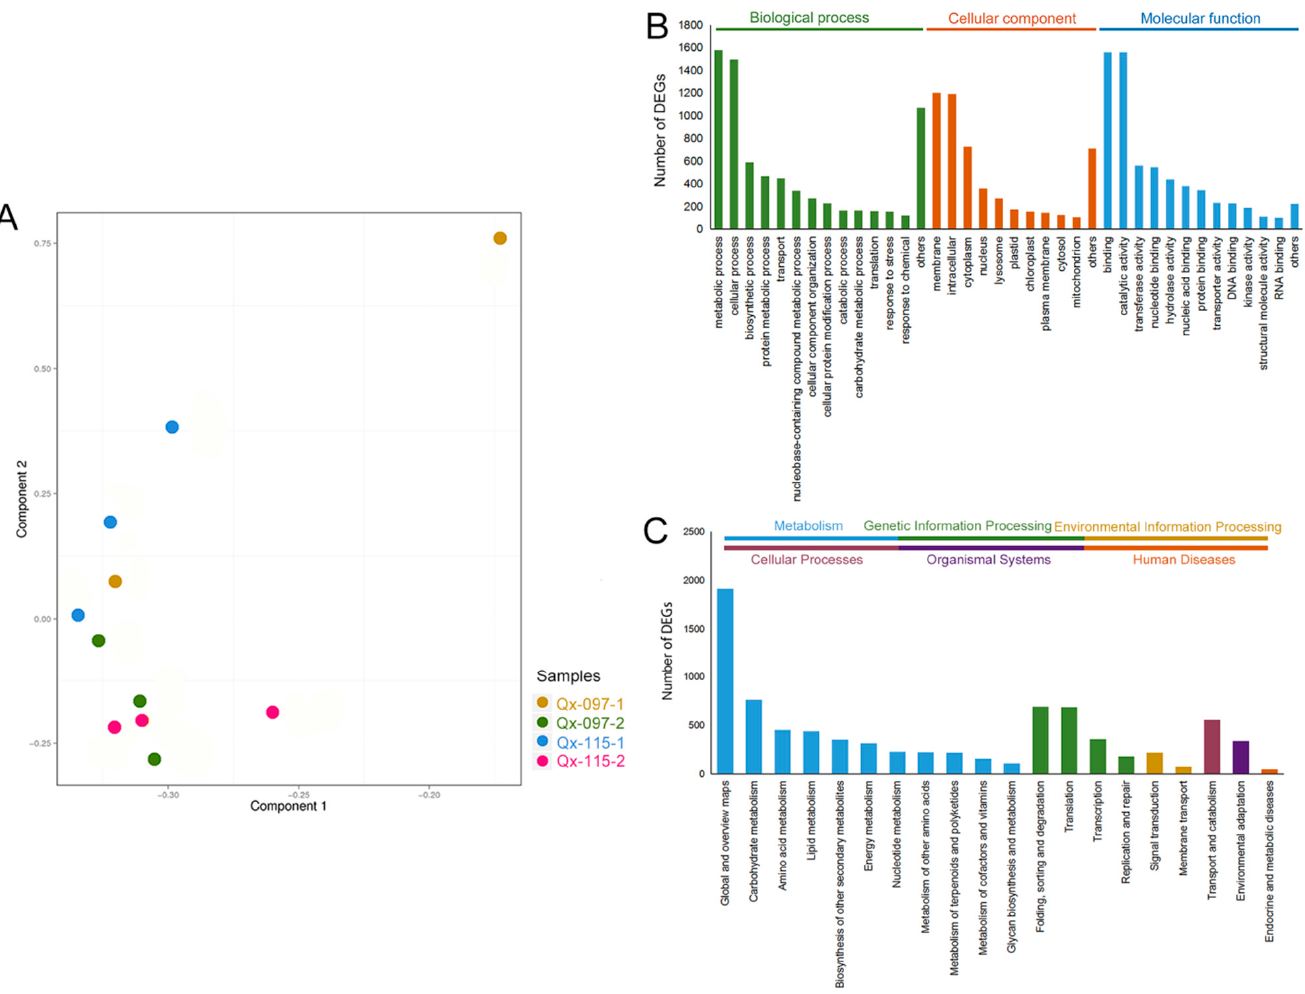
Figure 3. PCA analysis of transcriptome data and Gene Ontology (GO)/Kyoto Encyclopedia of Genes and Genomes (KEGG) enrichment analysis of differentially expressed genes (DEGs). ( A ) PCA analysis of transcriptome data. The same color dots represent replicates. ( B ) Histogram showing the number of DEGs annotated using GO classifications. ( C ) Histogram showing the number of DEGs annotated using KEGG classifications.